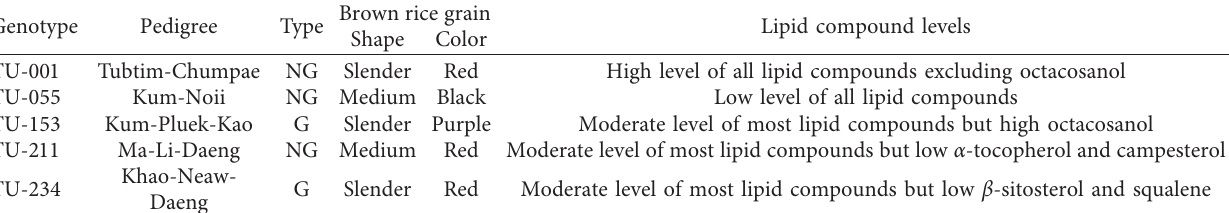
Table 1: Rice genotypes used in this study.